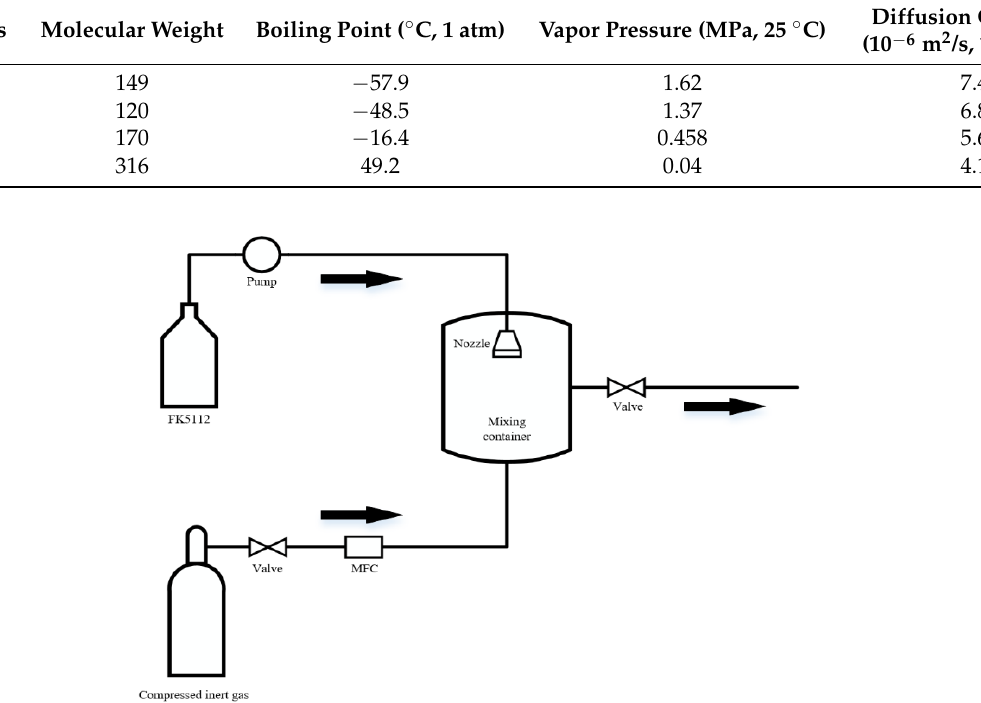
Figure 3. Device for improving the dispersibility of C 6 F 12 O by mixing inert gas [45]. Reprinted with permission from Ref. [45]. 2019, IEEE.